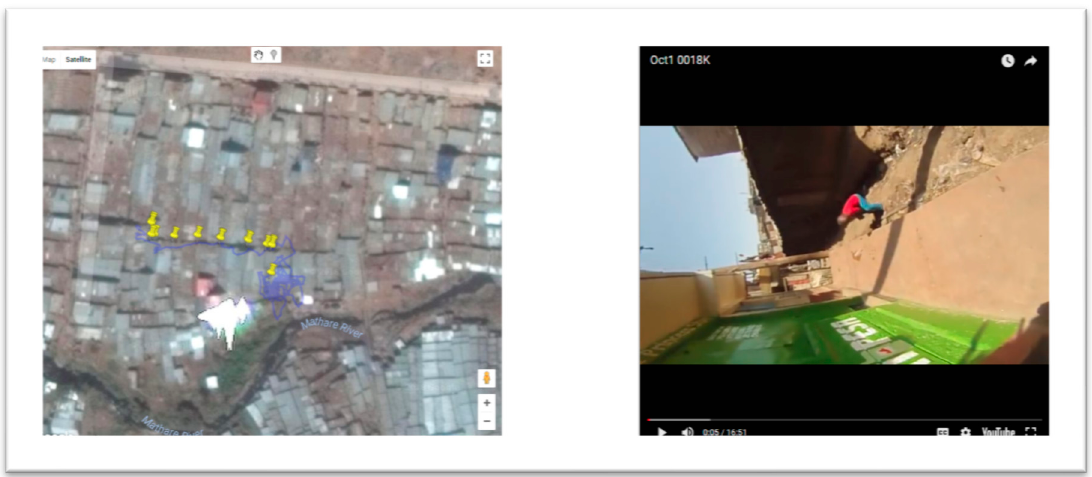
Figure 1. The software interface of the coordinate correction software; the left side shows the original global positioning system (GPS) path with yellow pins being used to create the new path. The image on the right is the spatial video (SV), and as can be seen, the image is sometimes challenging to work